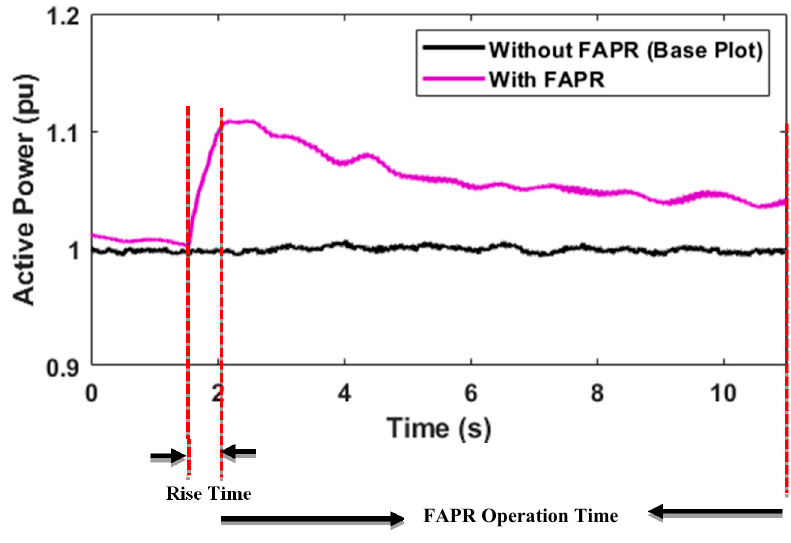
Figure 8. Illustration of FAPR control testing through PHIL.